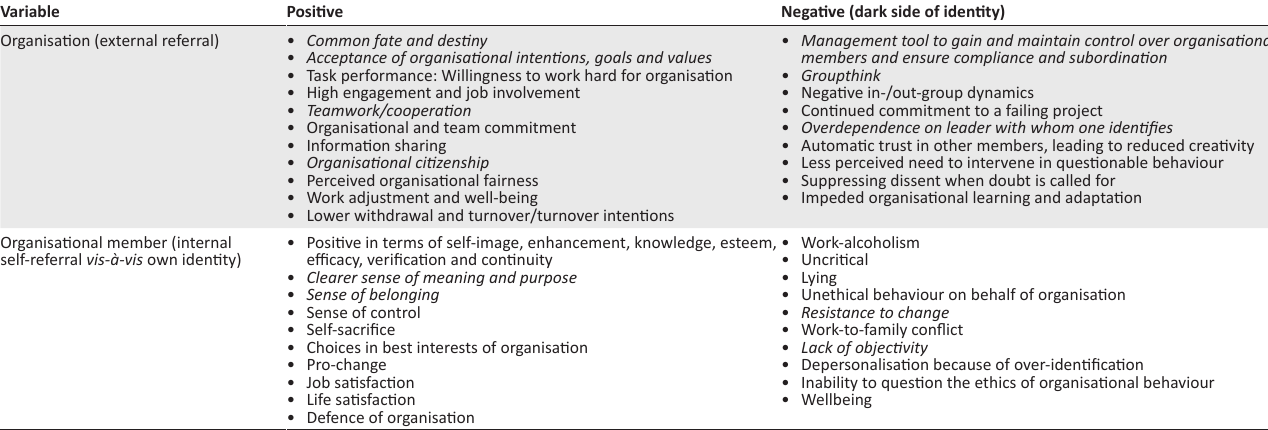
TABLE 3: Outcomes of a strong organisational identity for the organisation and organisational members.